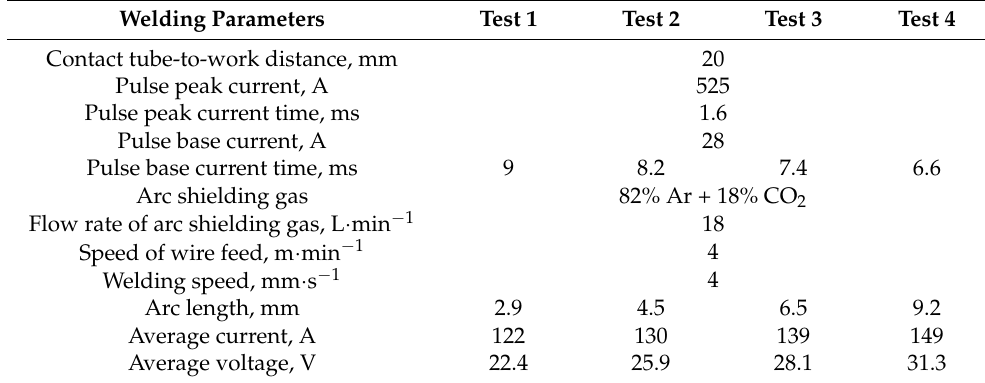
Figure 2. Schematic diagram of welded joints and selection of test specimens.